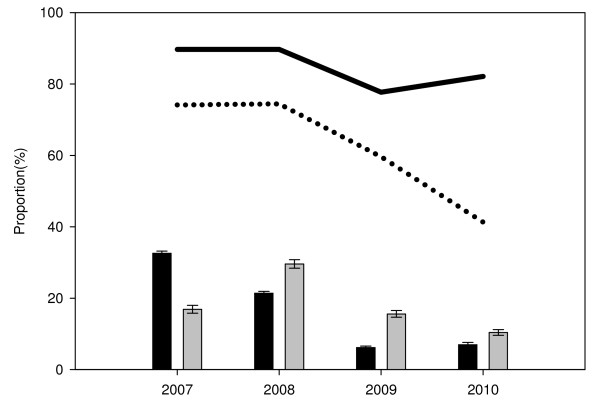
Sensitivity of RDTs by malaria parasite prevalence stratified by the year of study. Bars represent proportion of cases with positive blood smear results by microscopy by year of study from 2007 to 2010 (black bars = longitudinal study and grey bars = cross-sectional surveys - CSS); Solid line = sensitivity of RDTs in the longitudinal study and dotted line = sensitivity of RDTs in the cross-sectional surveys (CSS)